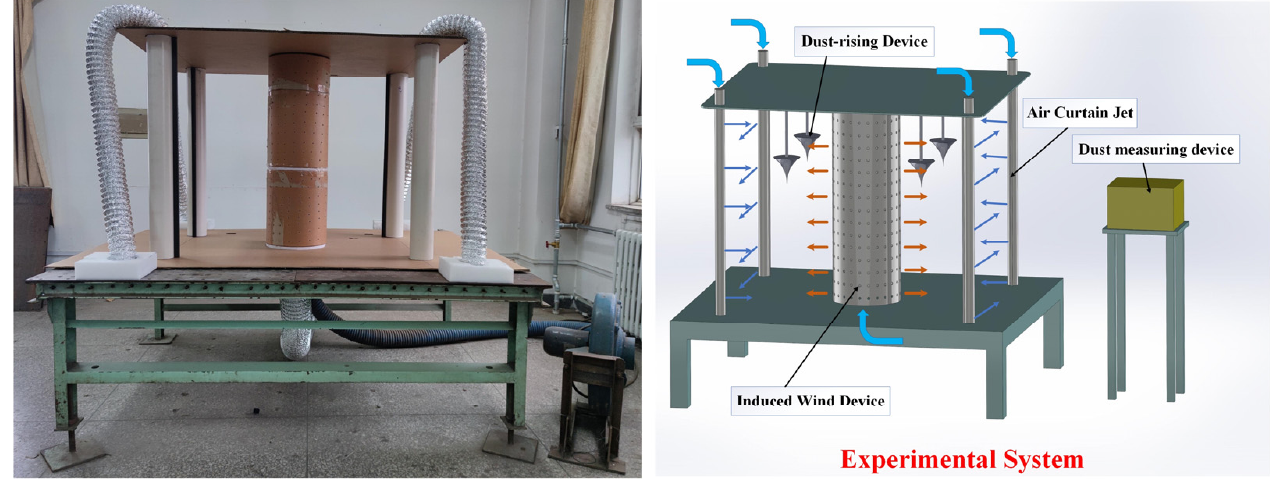
Figure 10. The experimental test of air curtain soft-sealing system.